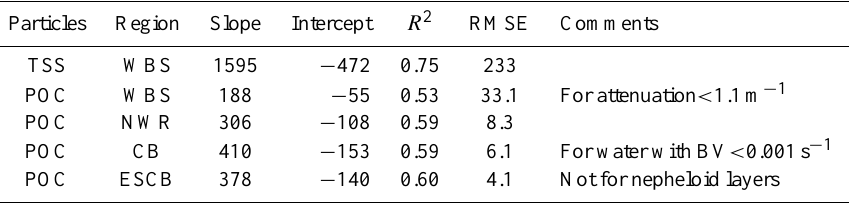
Table 3. TSS-attenuation and POC-attenuation statistics for regions that had good relationships ( R 2 value greater than 0.50 for all samples) between the bottle and sensor data. The symbols WBS stand for western Beaufort shelf, NWR for Northwind Ridge, CB for the interior of the Canada Basin, ESCB for the eastern shelf of the Canada Basin and BV the Brunt-V¨ais¨al¨a frequency. Units are (µgkg − 1 )m for TSS slope, (µgCkg − 1 )m for POC slope, µgkg − 1 for TSS intercept and µgCkg − 1 for POC intercept. Note that the relationships are written in opposite direction to those in Tables 1 and 2 so that TSS and POC are calculated from beam attenuation coefficient. Particles Region Slope Intercept R 2